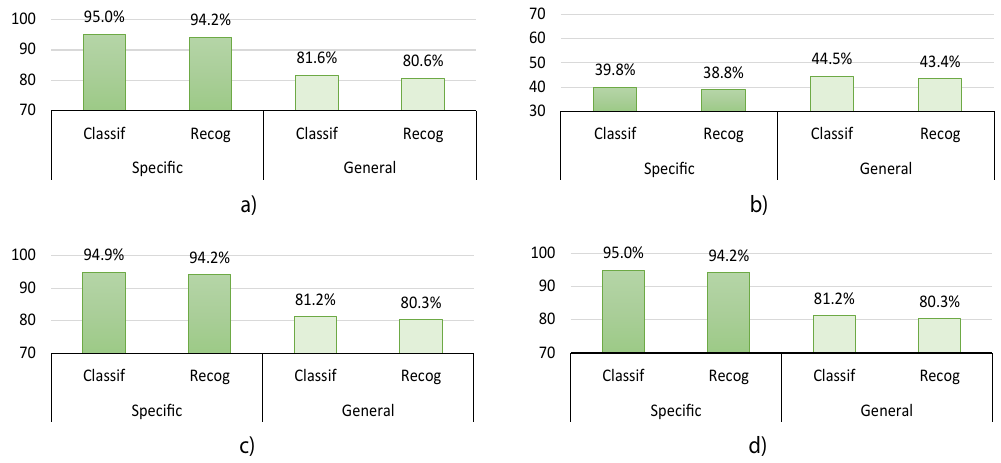
Figure 8. Hand gesture recognition (HGR) classification and recognition accuracy results for all users without taking into account sex or handedness preference information for user-specific and user-general models obtained for ( a ) experiment 1 , ( b ) experiment 2 , ( c ) experiment 3 , and ( d ) experiment 4 .